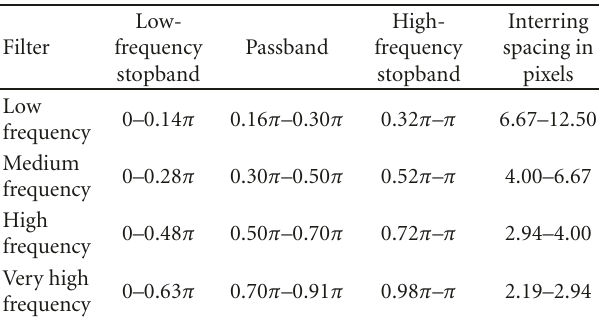
Table 2: Variable frequency spacing specifications for the spruce images. The vertical filter parameters for the four filters are given in the table. Horizontally, for the row filter, the left stopband was from – π to − 0.85 π , the passband went from − 0.65 π to 0.45 π with the right stopband from 0.65 π to π . All separable filters used 45 coe ffi